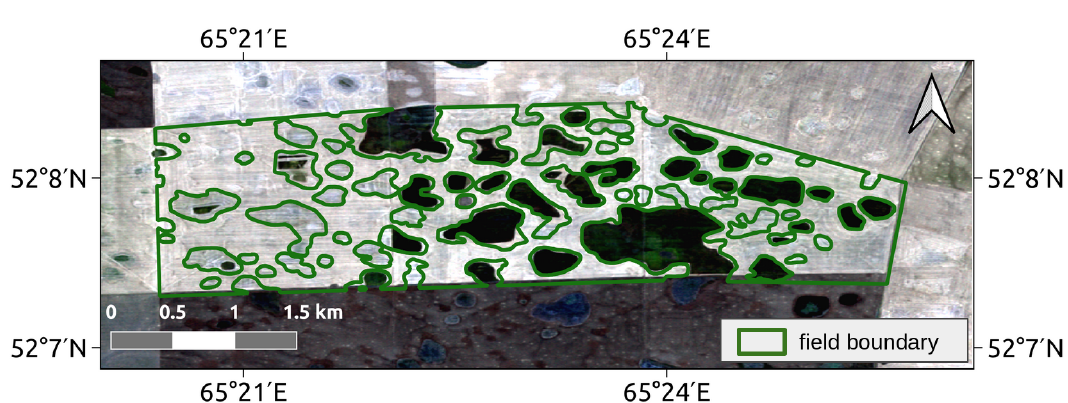
Figure 2. Example of a heterogeneous field (Sentinel-2 satellite image, date of acquisition 26 September